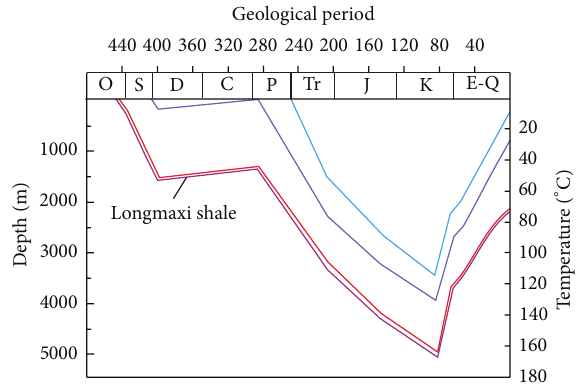
Figure 3: The burial and thermal history of the Py1 well area in southeast